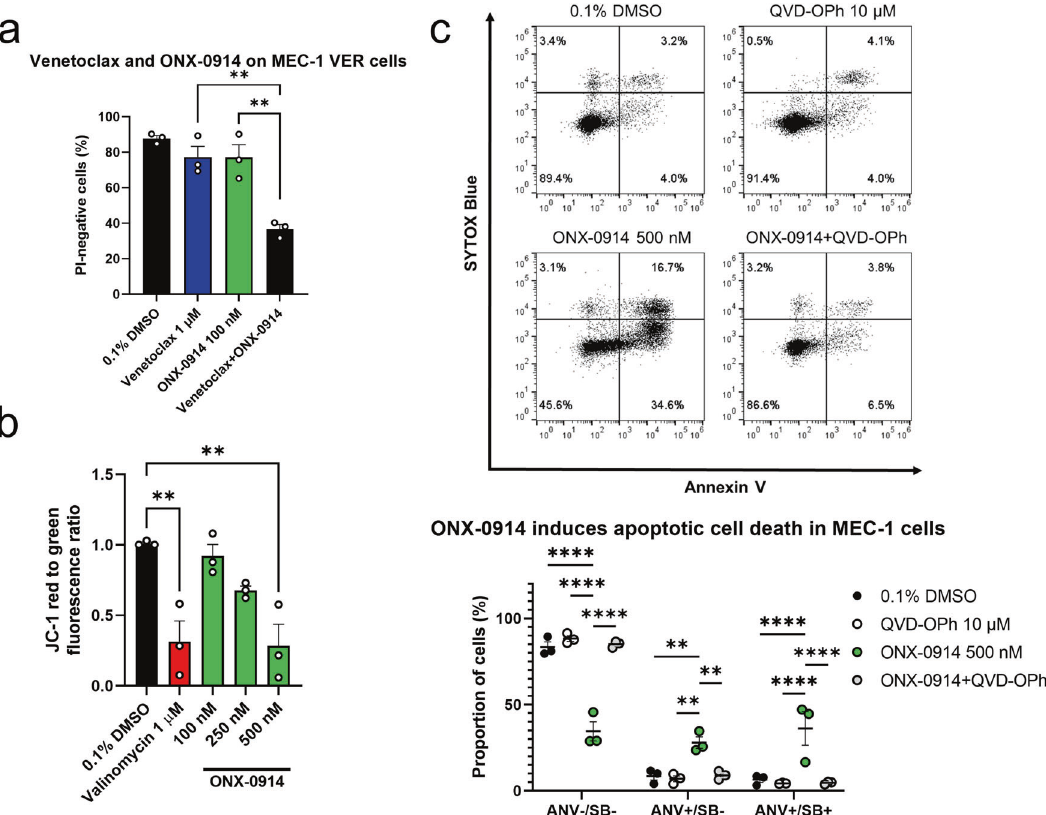
Fig. 4 Immunoproteasome inhibitor ONX-0914 overcomes resistance of MEC-1 VER cells to venetoclax. a MEC-1 VER cells (3 × 10 5 cells/mL) were treated with 0.1% DMSO (vehicle control), 1 µM venetoclax, 100 nM ONX-0914 and their combination for 24 h. Then, the samples were stained with 5 µM propidium iodide (PI) and analyzed using fl ow cytometry. Data are means ± SEM of three independent experiments, each carried out in duplicate. One-way ANOVA (post hoc Dunnett); ** denotes p < 0.01. b ONX-0914 disrupts mitochondrial membrane potential. MEC-1 cells (3 × 10 5 cells/mL) were treated with 0.1% DMSO or 100, 250, and 500 nM ONX-0914 for 24 h and with 1 µM valinomycin (positive control) for 1 h. Then, the samples were stained with JC-1 probe and analyzed using fl ow cytometry. Data are means ± SEM of